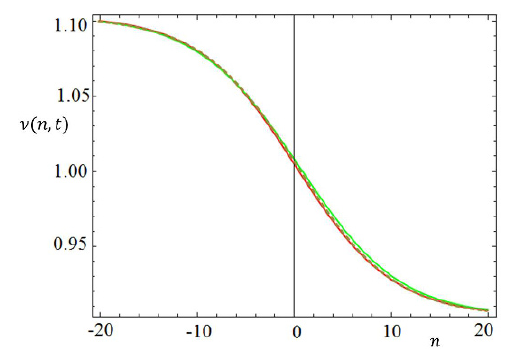
( n,t ) as in Eq. , λ = 1 ; Green line 10 10